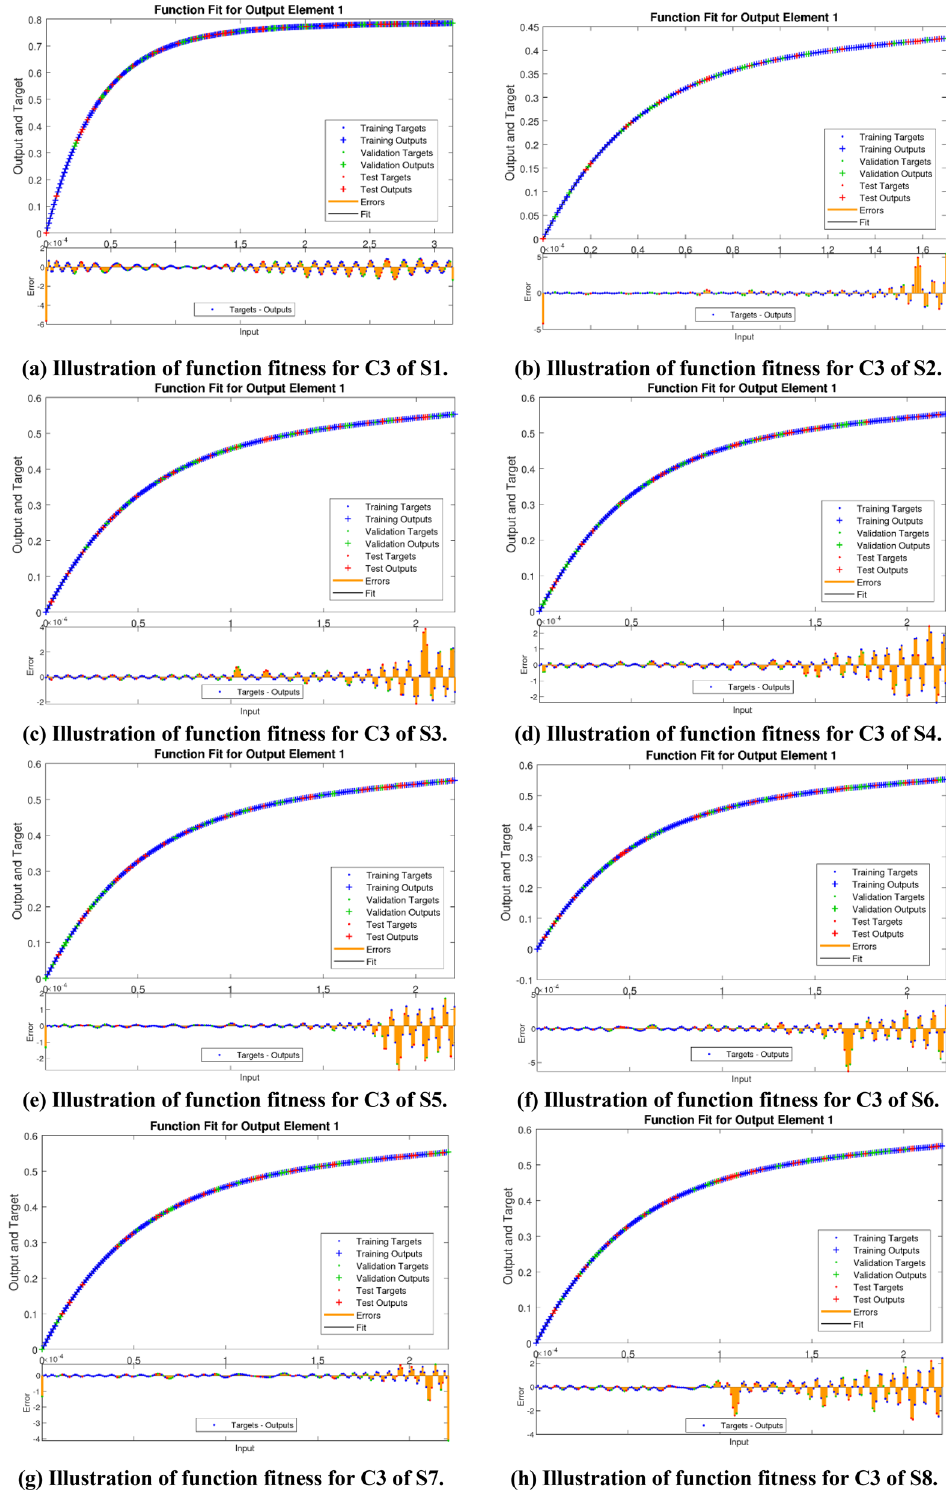
Figure 7. Fitness graphs of C3 of all eight